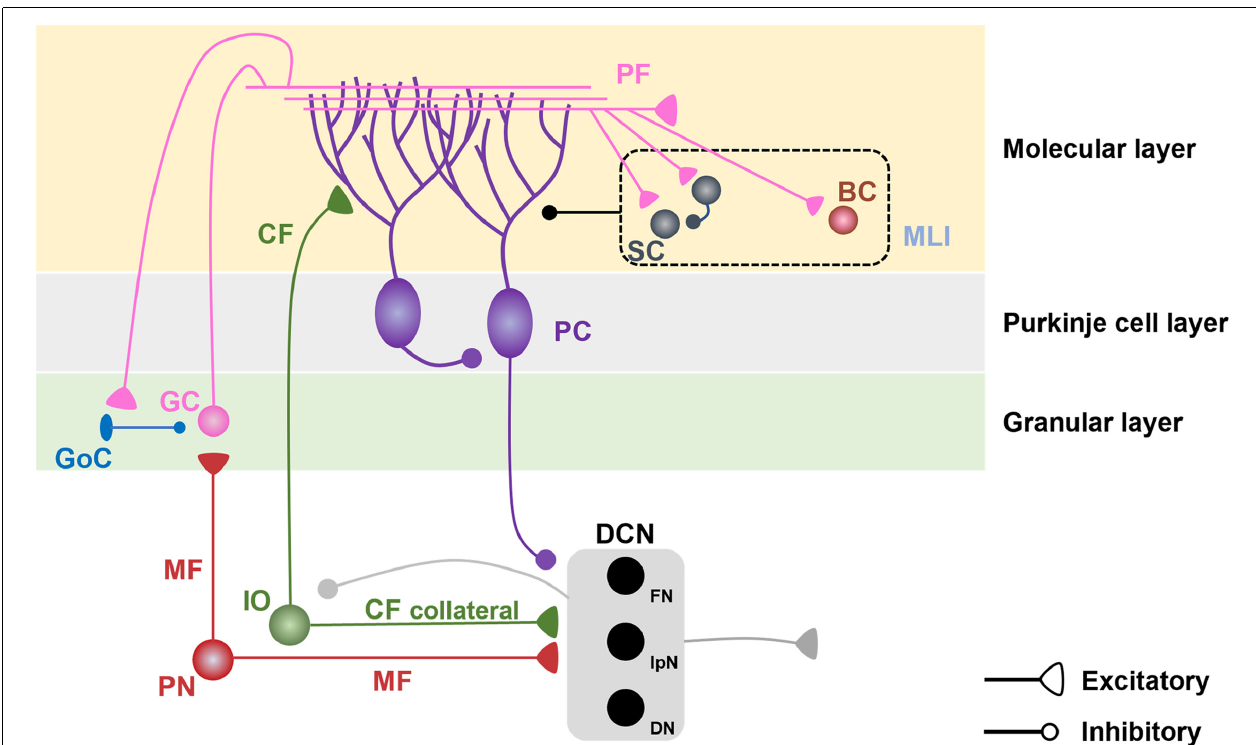
FIGURE 1 | Cerebellar microcircuits. Pontine nuclei send excitatory projections to cerebellar granule cells (GCs) and deep cerebellar nuclei (DCN) via mossy fibers (MFs). GCs, which receive inhibitory inputs from Golgi cells (GoCs) in the granular layer, send excitatory projections to the dendrites of Purkinje cells (PCs) and molecular layer interneurons (MLIs), including stellate cells (SCs) and basket cells (BCs) in the molecular layer. MLIs send inhibitory projections to PC dendrites and have reciprocal inhibitory connections among SCs. The inferior olive (IO) sends excitatory projections to PC dendrites and DCN via climbing fibers (CFs) and their collaterals. PCs send inhibitory projections to the DCN and neighboring PCs. The DCN sends excitatory projections to the extracerebellar regions and inhibitory projections to the